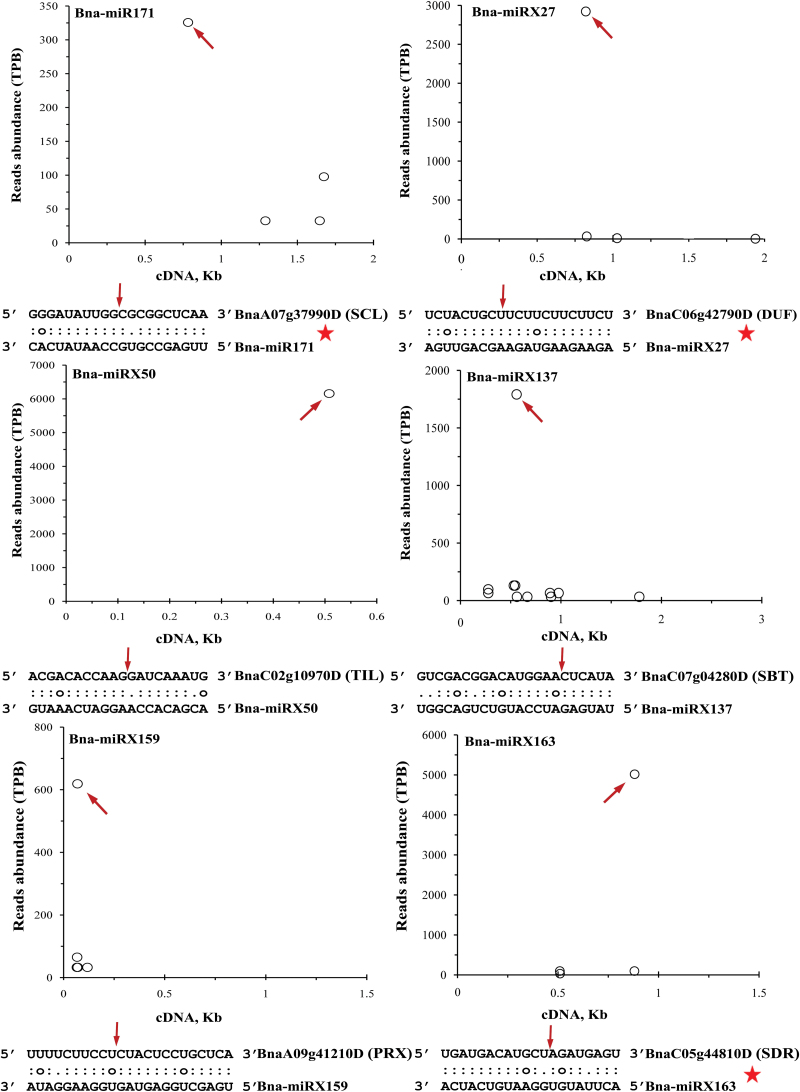
Identification of candidate targets of miRNAs by degradome experiments. Six targets of one conserved and five novel miRNAs are shown in the panels as an example. The x-axis indicates the position of target genes while the y-axis represents the abundance of sequenced reads. Each circle is a degradome fragment that can be mapped to the corresponding target gene and the arrows indicate the expected miRNA positions. The putative miRNA-binding sites are depicted within the corresponding target transcripts within the sequence alignments. The cleavage sites deduced from the degradome data are indicated by the arrows. The stars indicate the cleavages validated by the 5’RLM-RACE assays. (This figure is available in colour at JXB online.)